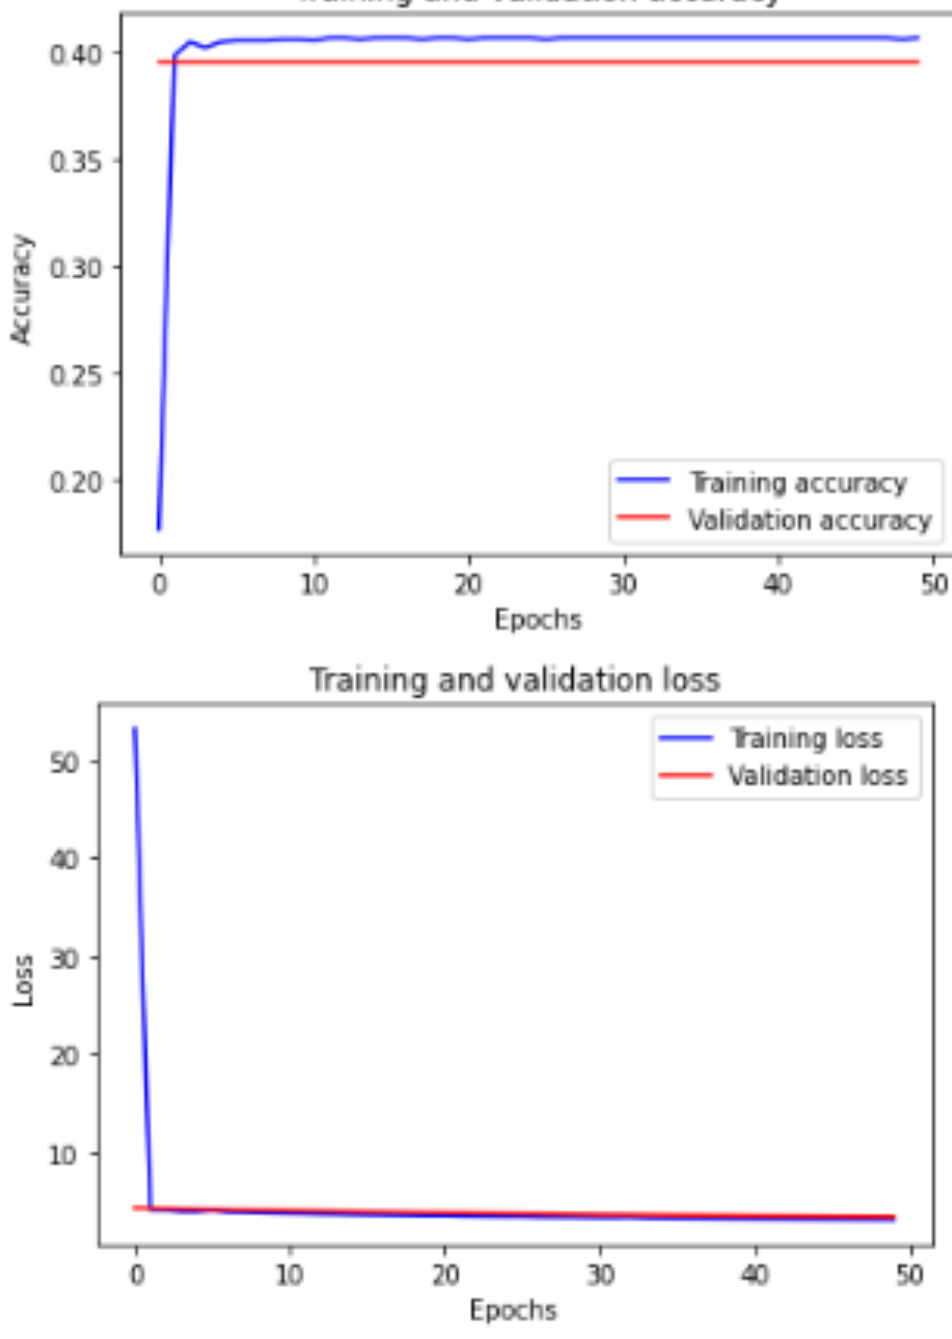
Figure 16. The training and validation ACC and loss through 50 epochs of the InceptionResNetV2